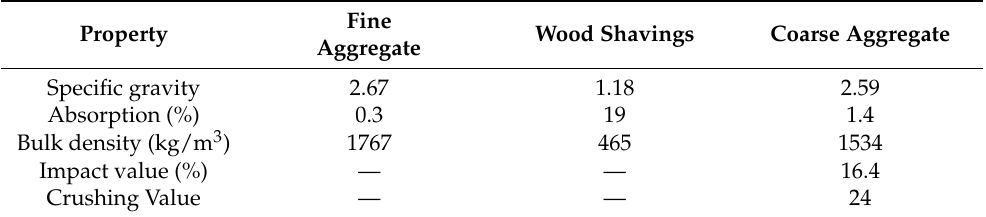
Table 3. Properties of fine, coarse aggregates and wood